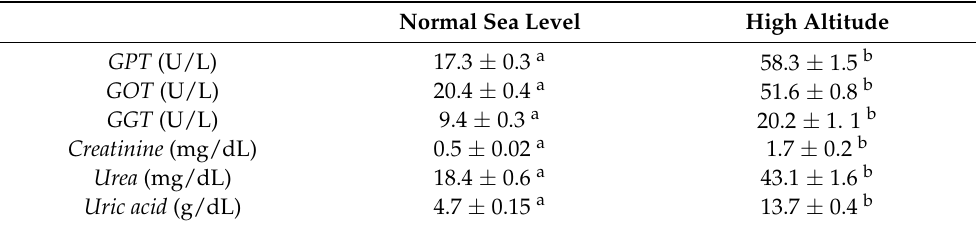
Table 2. Alterations in serum liver and kidney biomarkers in groups living at normal sea levels and at high altitude.